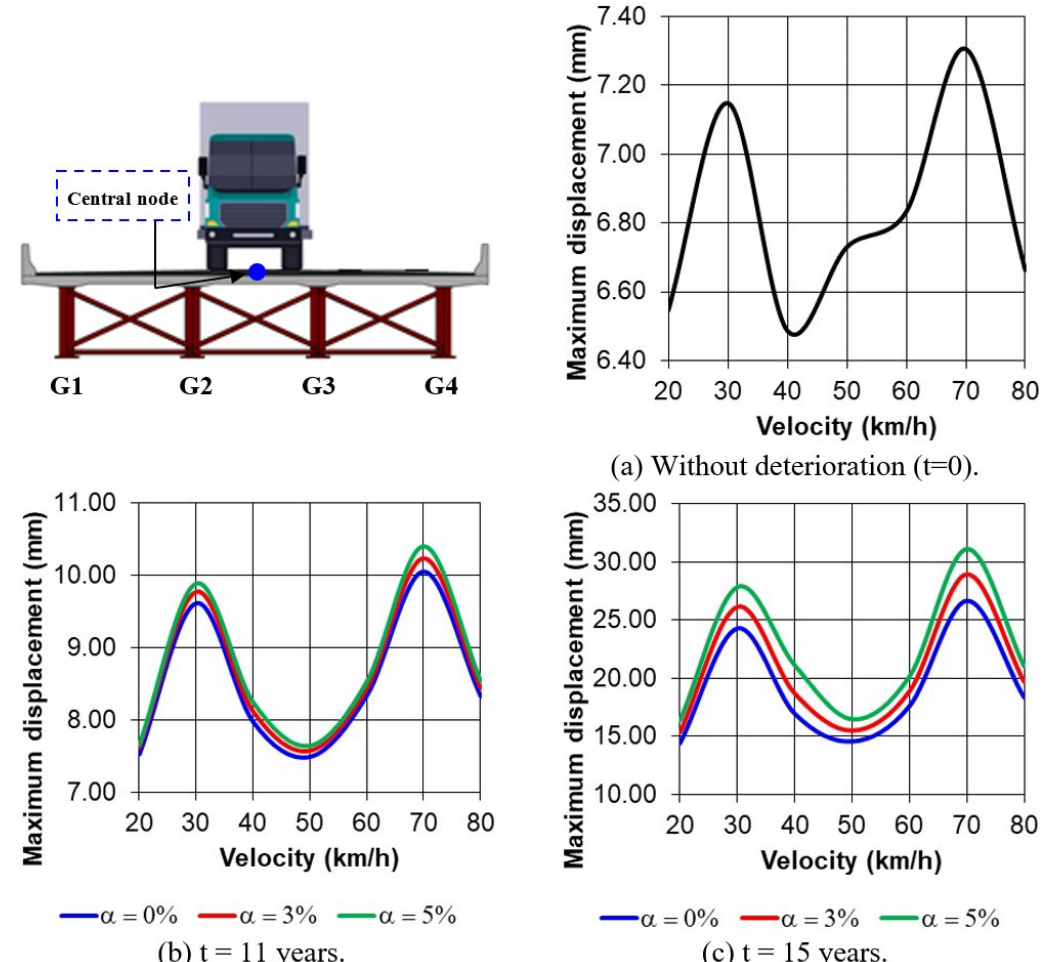
Figure 11. Response spectra: translational vertical displacements (see Figure